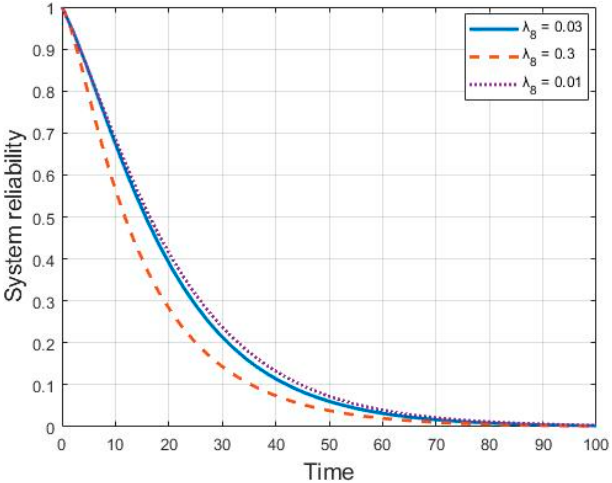
Figure 7. System reliability comparison with the changes of failure rate λ 8 .